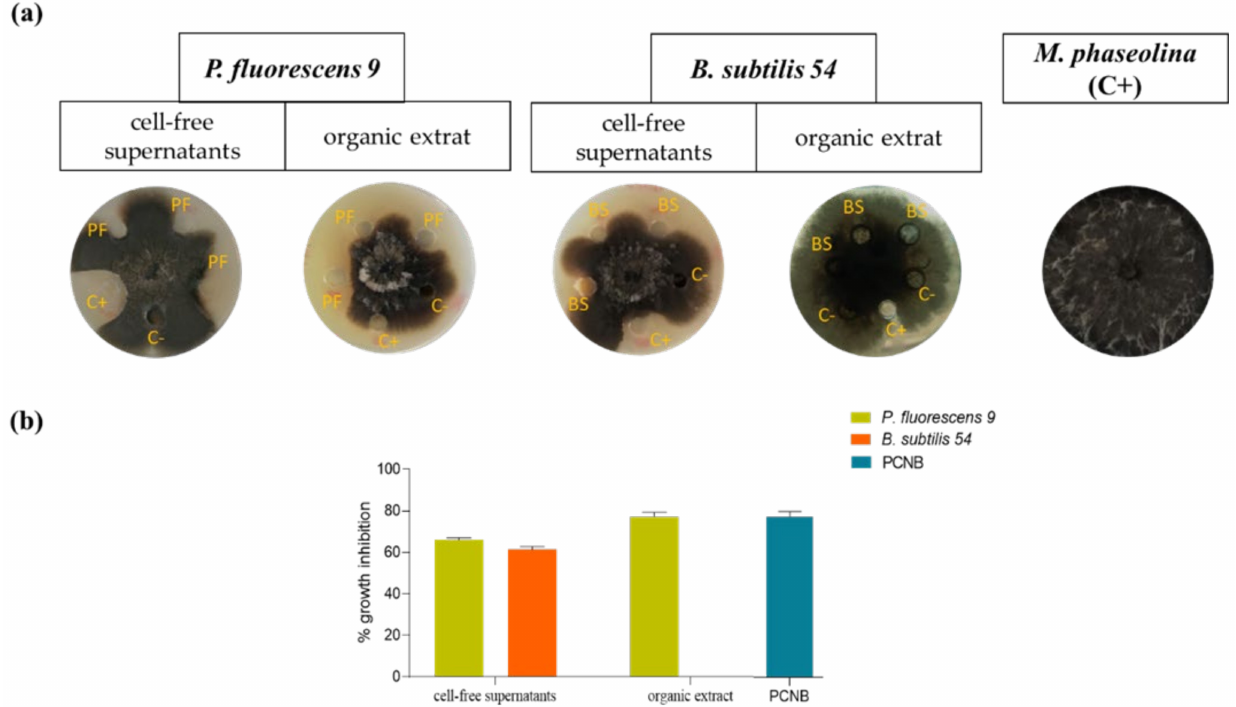
Figure 1. Antifungal activity of cell-free supernatants (CSFs) and respective organic extracts of P. fluorescens 9 and B. subtilis 54 against M. phaseolina . ( a ) CSFs of bacterial strains collected after 72 h of growth and the respective organic extracts were tested for their ability to inhibit the mycelial growth of M. phaseolina . C+: positive control, pentachloronitrobenzene (PNCB) 0.5 mg/mL; C − : negative control, toluene. All experiments were performed in triplicate with three independent trials. ( b ) The percentage inhibition of fungal growth was reported as the percentage reduction in the diameter of the fungal mycelia compared to the control plate. Data are presented as means ± standard deviation ( n = 3). For comparative analysis of groups of data, one-way ANOVA was used; p -values were extremely significant ( p <